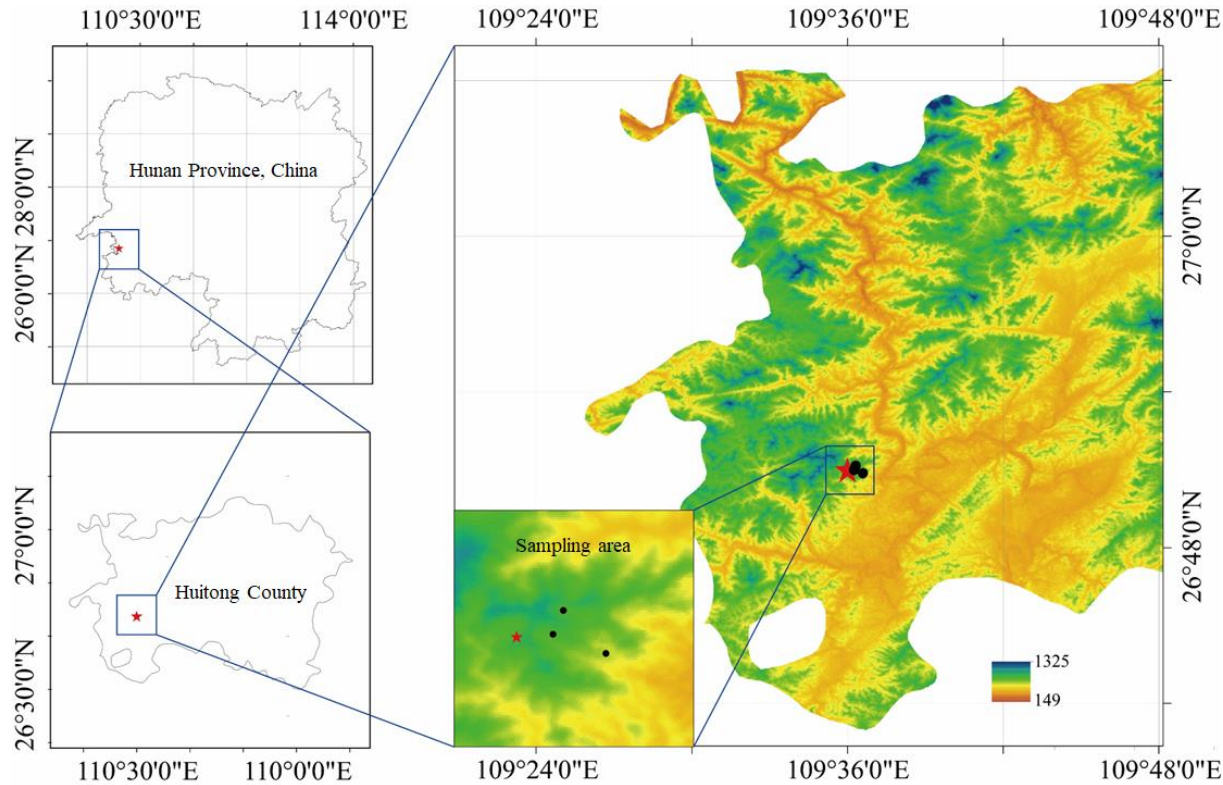
Figure 1. Study area showing location of the sample plots in an evergreen broad-leaved secondary forest of China.